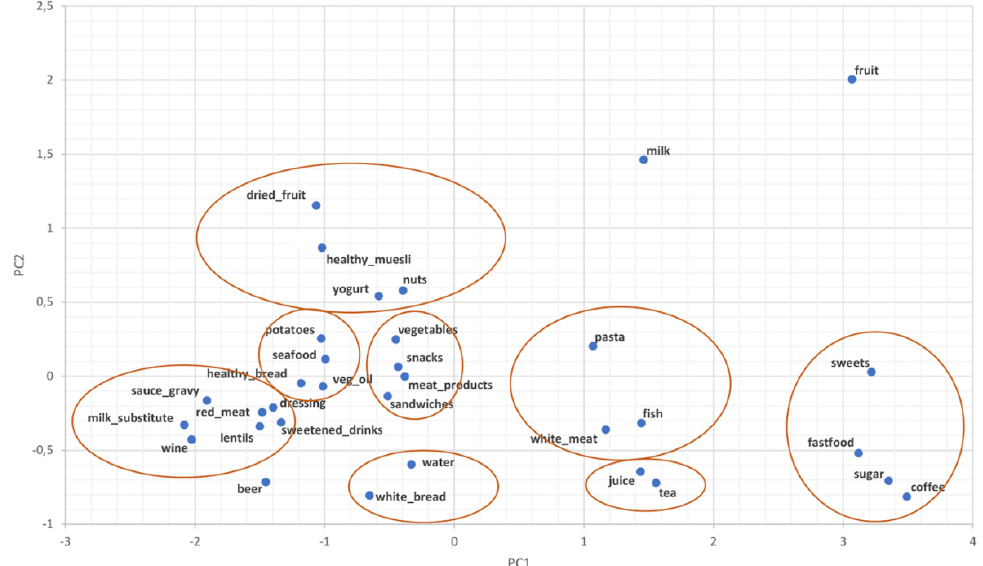
Figure 3. Principal component analysis (PCA) loadings plot of the cumulative frequencies of food